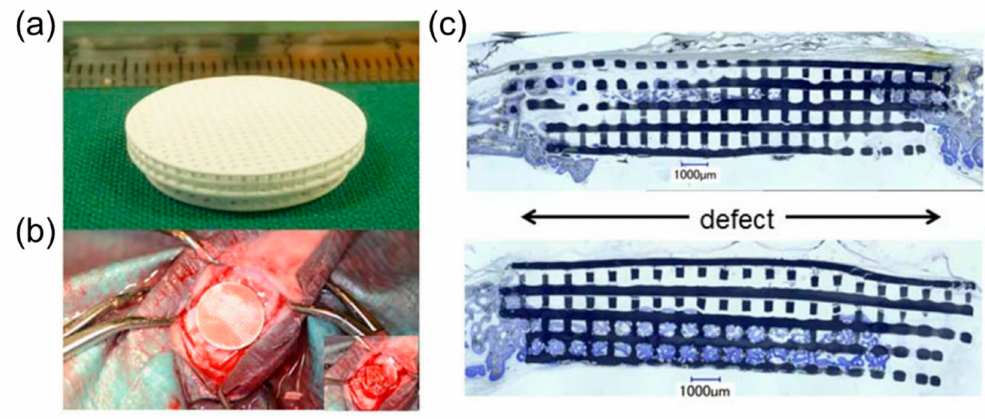
Figure 6. Critical size bone defect healing assessed with ( a ) a tri-calcium phosphate sca ff old ( b ) implanted in a rabbit bone with ( c ) post-op histological section after sixteen weeks. The sca ff old appears greyish black and the bone appears purple in the histology image; the distorted lattice structure and gaps indicate failure. Images adapted with permission